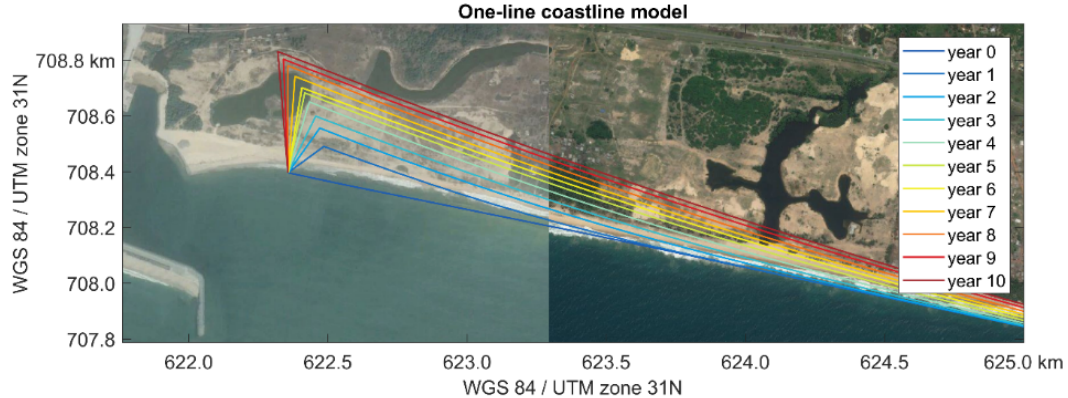
Figure 11. Simulated coastline development at the eastern side of the port after the construction of the Sandbar Breakwater using a one-line coastline model.